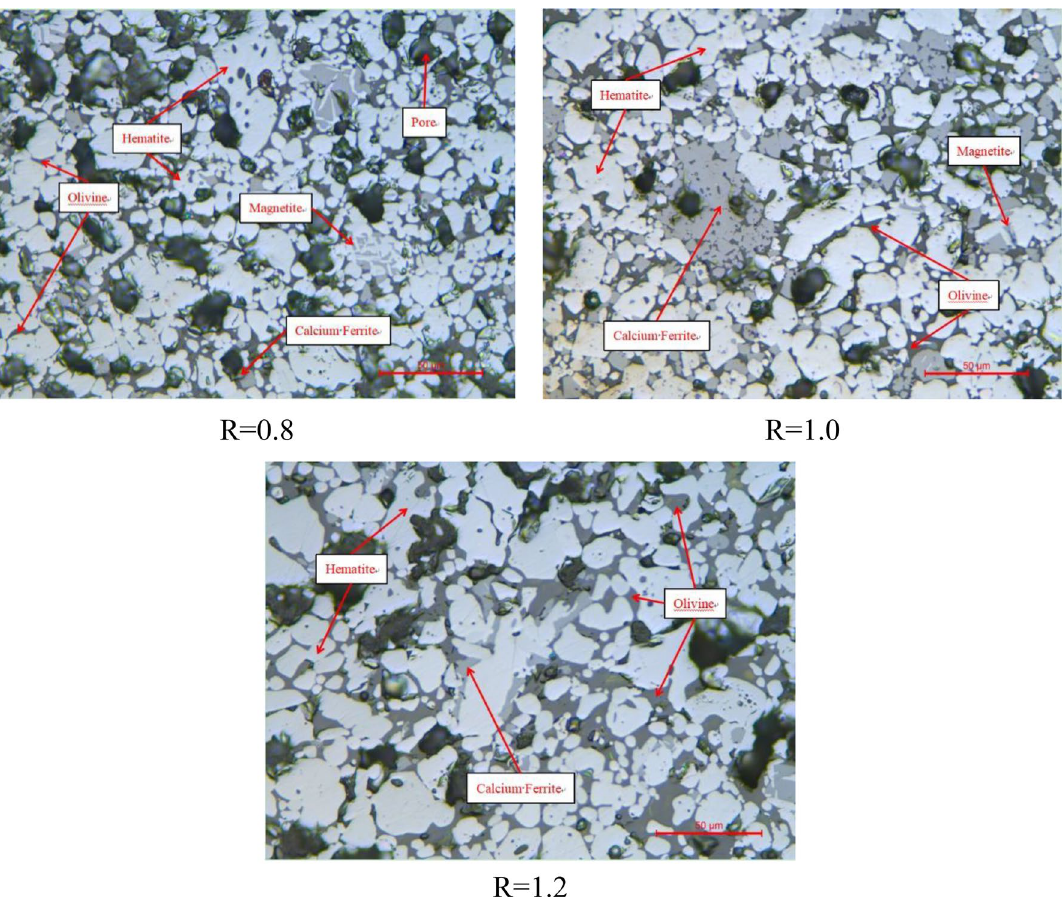
Figure 4. Mineral phase structure of briquettes with different basicity, reflected light(×